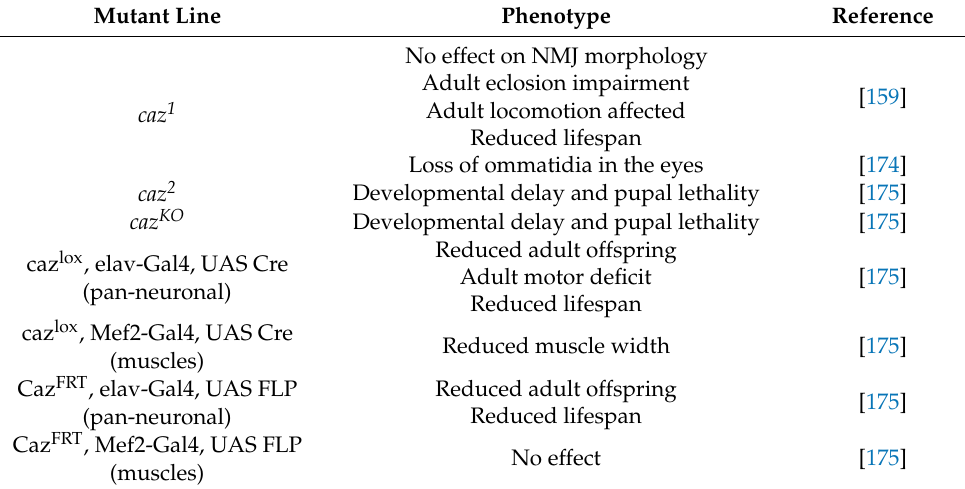
Table 4. Phenotypes observed in cabeza